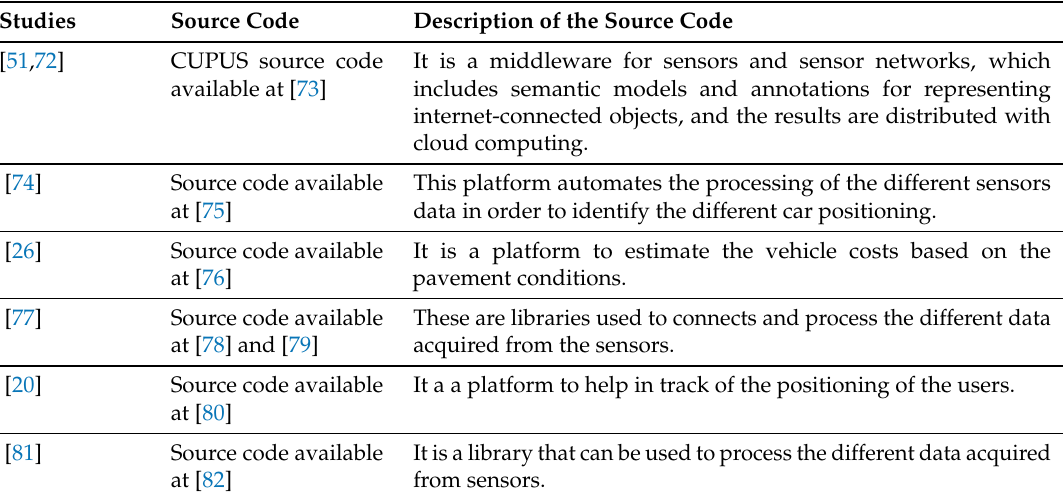
Table 5. Source code analysis of all searched